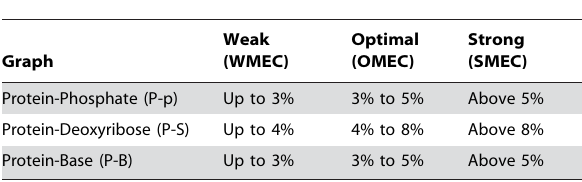
Table 1. Range of minimal effective connection